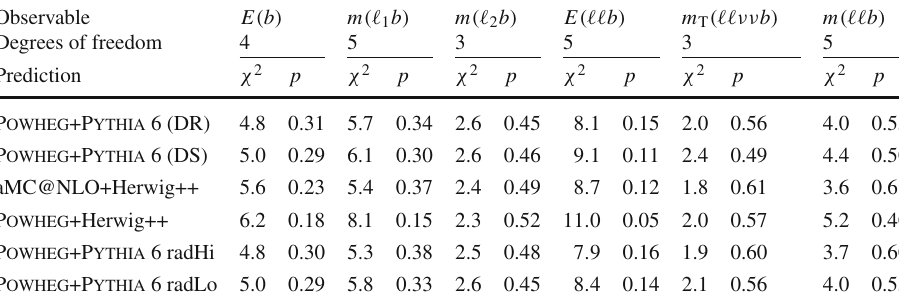
Table 5 Values of χ 2 and p values for the measured normalised cross-sections compared to particle-level MC